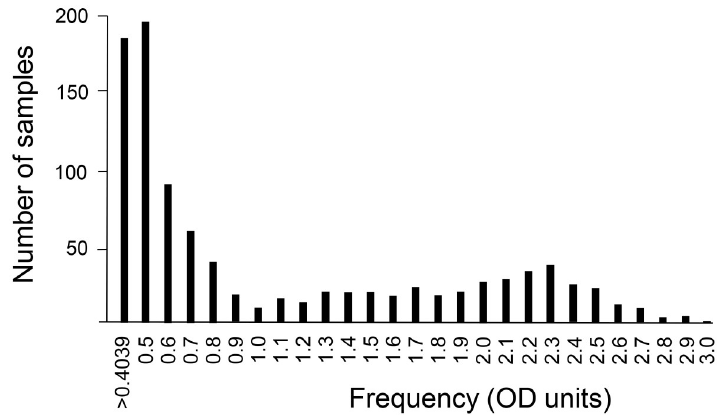
Fig 1. Histogram frequency of positive S protein ELISA OD values from 0.4039 to 3.000. The 802 Spike positive samples in our assay were grouped in bins of 0.1 OD units with the initial bin starting at 0.4039, the minimum positive Spike OD value. The maximum Spike OD of all samples was